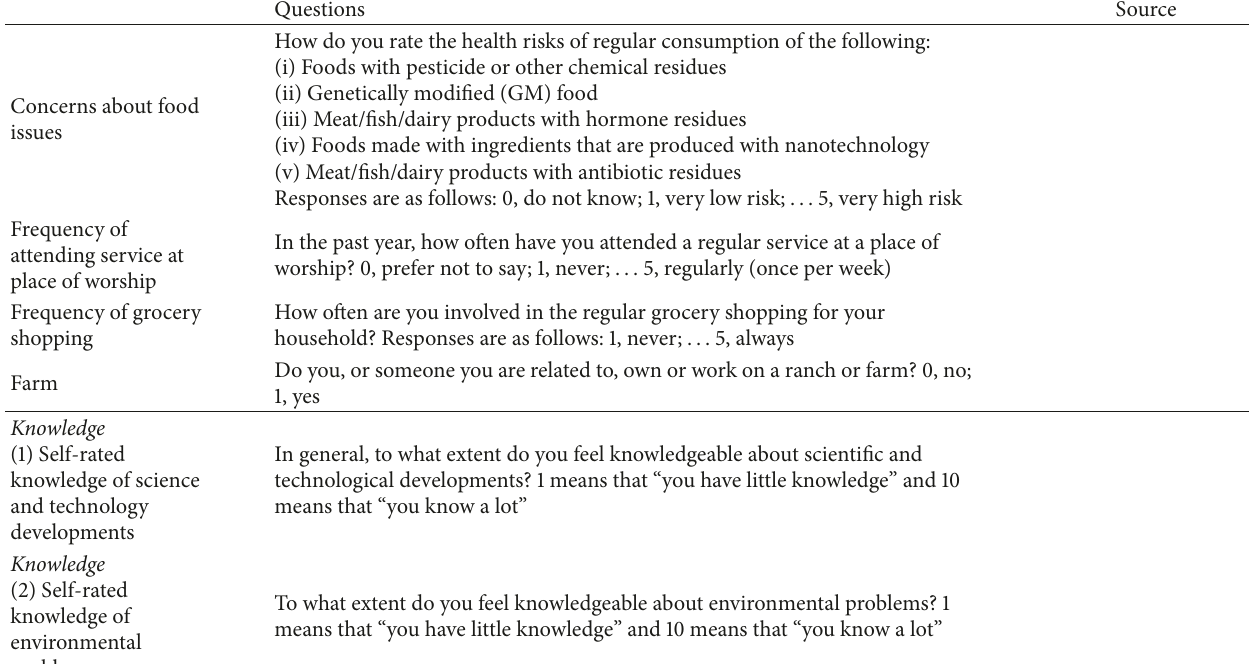
Table 1: Questions used to measure